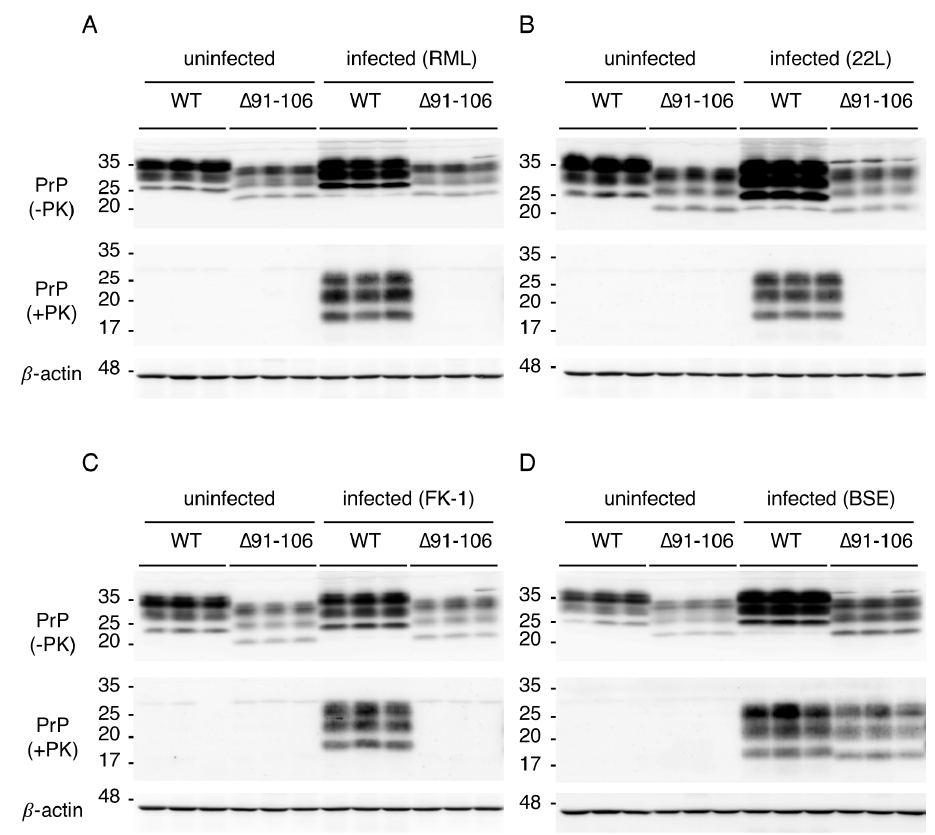
Figure 3. Accumulation of PrP Sc ∆ 91–106 in the brains of Tg(PrP ∆ 91–106)/ Prnp 0/0 mice inoculated